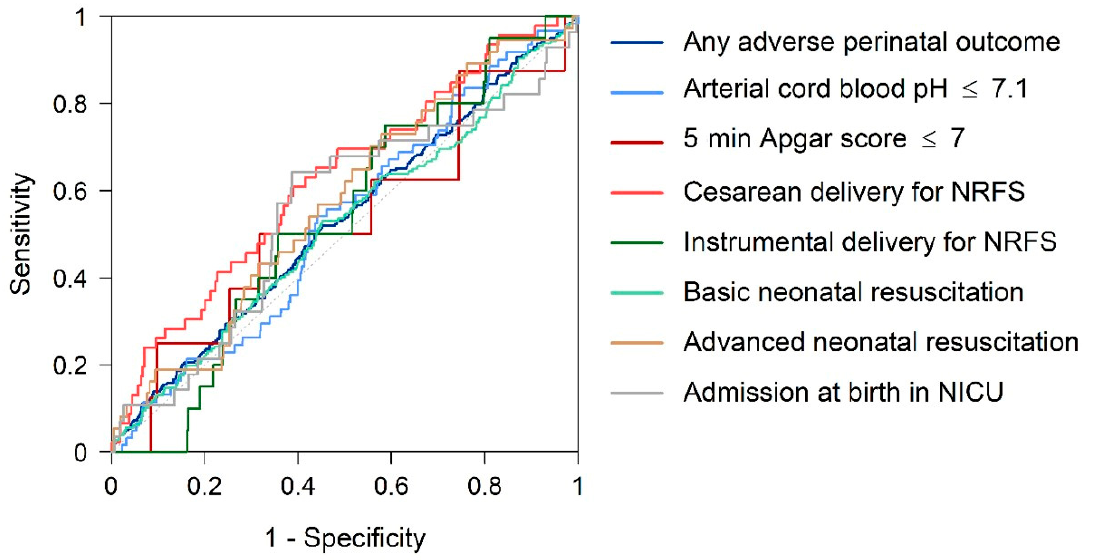
Figure 2. Receiver operating characteristic curves: fetal growth detention as predictor of adverse perinatal outcomes (APOs). NRFS: non-reassuring fetal status.